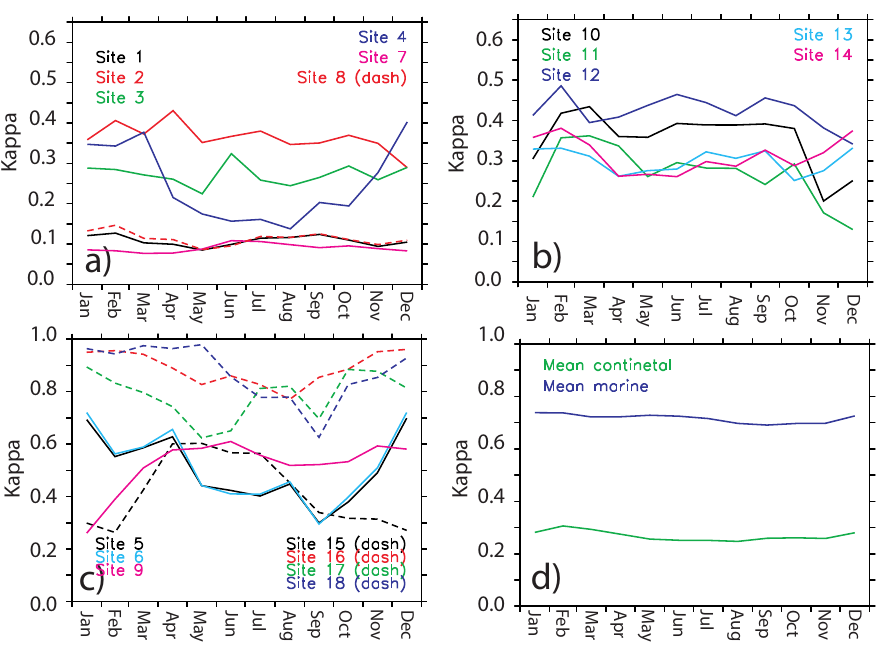
Fig. 5. Annual cycle of monthly mean κ at the surface at sites shown in Fig. 4. Plots (a) and (b) show continental sites plot (c) shows continental sites with strong marine influence (solid line) and marine sites (dash) and plot (d) shows the annual cycle of the global mean of all continental and all marine regions. Note y-axis changes between